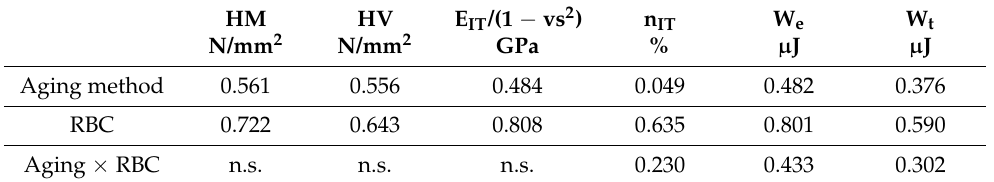
HM HV n IT W e W t E IT /(1 − vs 2 ) µ J µ J N/mm 2 N/mm 2 % GPa